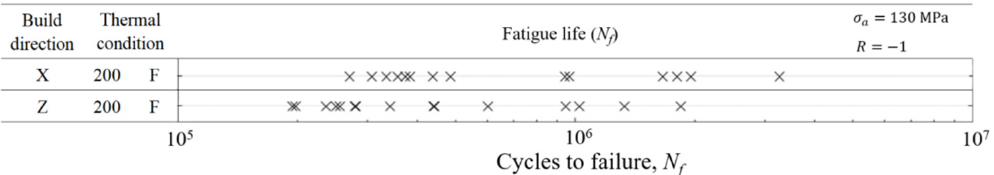
Figure 10. Fatigue life from rotating-bending fatigue tests at 130 MPa for 200 ◦ C condition (X and Z building conditions).